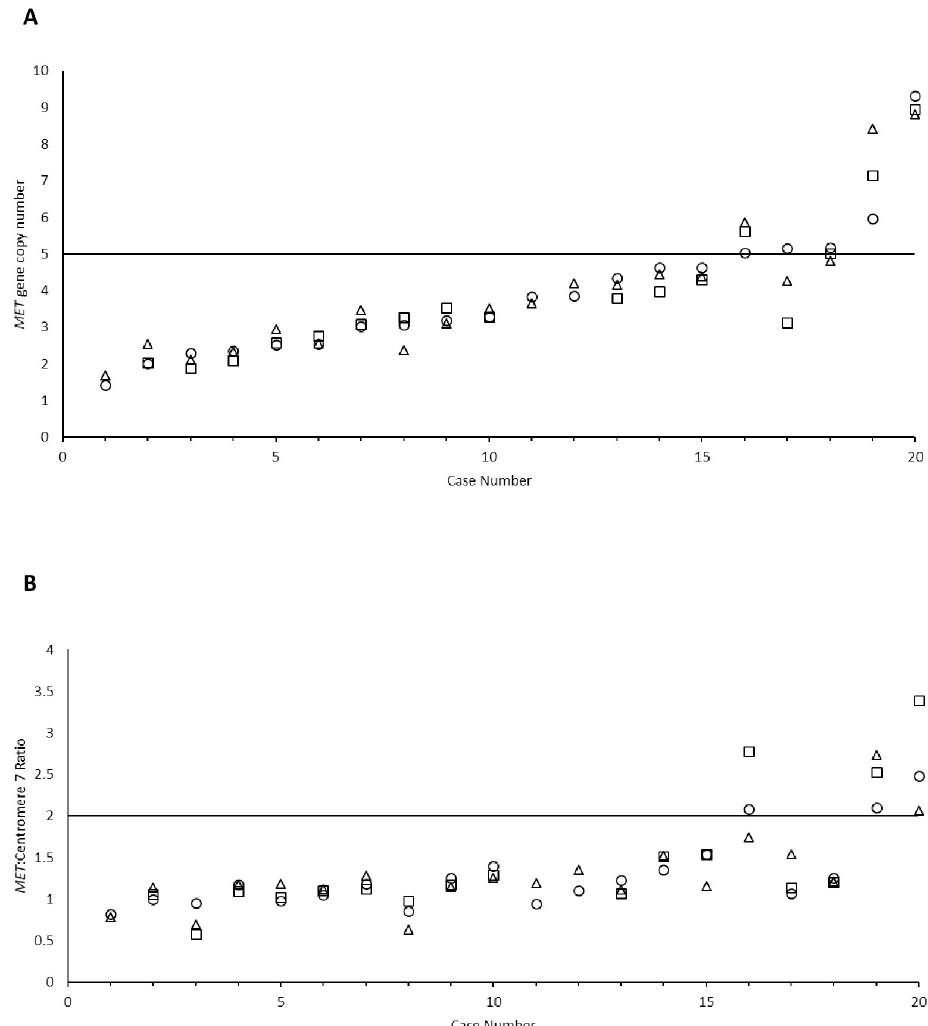
Fig 1. MET gene copy number (A) and MET : Centromere 7 ratio (B) of cases probed with the standard Kreatech assay (circles), fast Dako assay (triangles) and fast Kreatech assay (squares). Horizontal line represents the threshold to determine MET high or MET low status. Overall MET status showed discordance for cases 17 and 18. Although MET : Centromere ratio of case 16 falls either side of the cut off, the MET gene copy number status for this case was high using all three assays. Cases 1, 11 and 12 were not evaluated using the fast Kreatech assay.